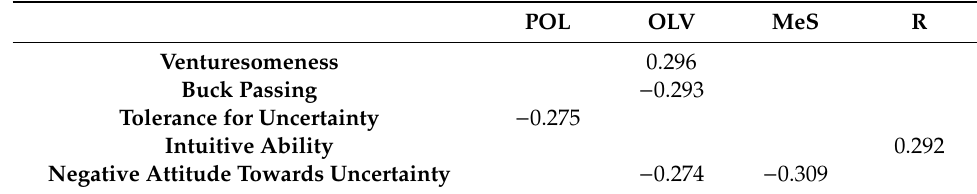
Table 2. Significant correlations between complex problem-solving strategies‘ parameters and psychological